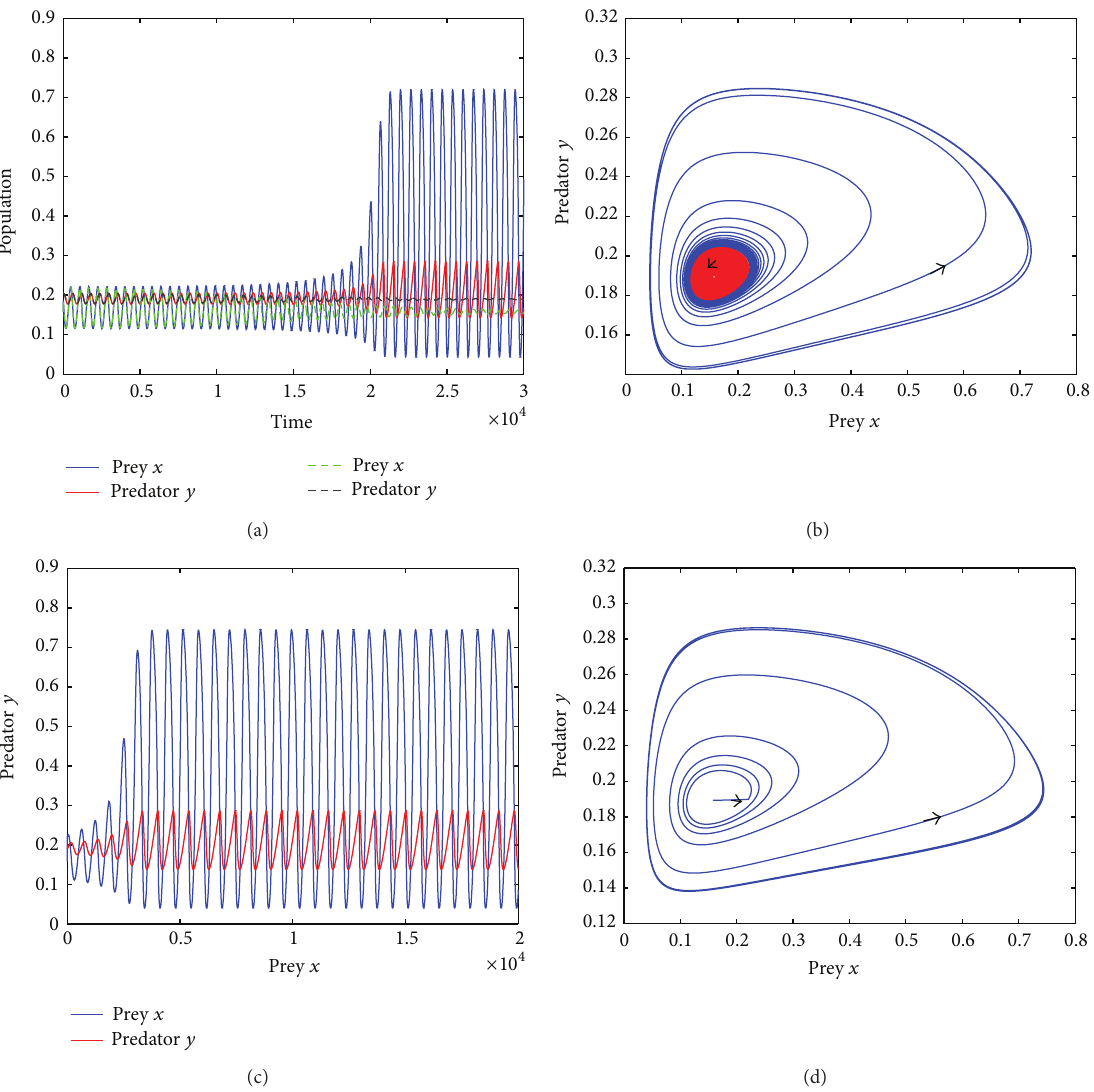
Figure 6: The trajectory graphs and phase portrait of system (6) for (𝛼,𝛽) ∈ 𝐷 2 with 𝛼 = 0.2 , 𝛽 = 1.2 , and 𝛾 = 0.04 . (a)-(b) For 𝜏 = 0.2 ∈ ) , the positive equilibrium 𝐸 ∗ is stable with small-amplitude unstable and large-amplitude stable periodic orbits. The initial values are [0,𝜏 0 𝐸 ∗ is unstable with a large-amplitude stable periodic (0.1578, 0.21532) and (0.1578, 0.21533) . (c)-(d) For 𝜏 = 0.4 > 𝜏 0 , the positive equilibrium orbit. The initial value is (0.1578, 0.18935)